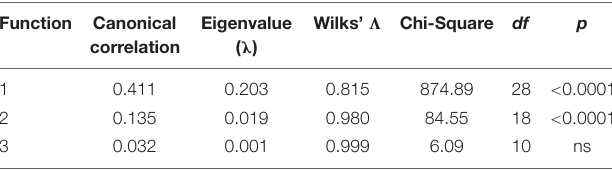
TABLE 3 | Significance tests, eigenvalues ( λ ), Wilks’ (cid:51) , and canonical correlations of the discriminant functions for groups defined by gender and cohorts of students.